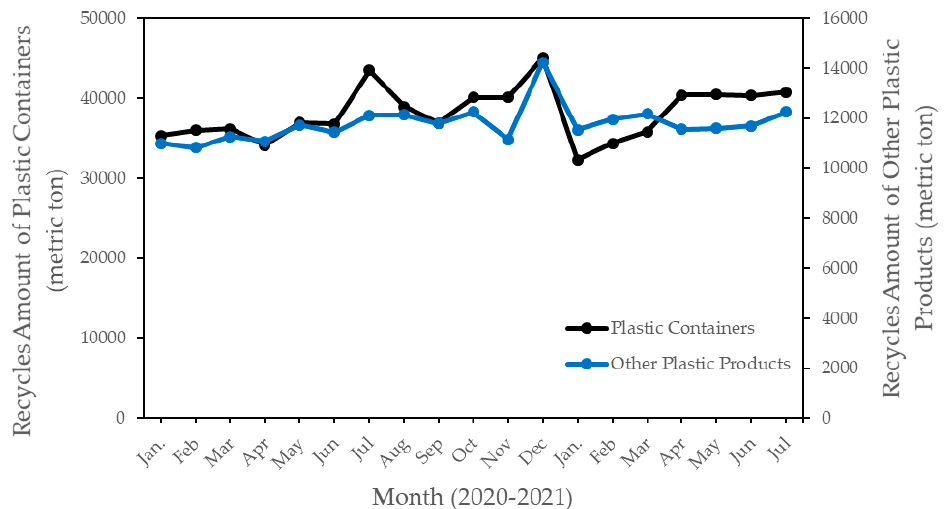
Figure 4. Monthly variations in plastic containers and other plastic products recycled by implementing agencies from January 2020 to July 2021 [19].